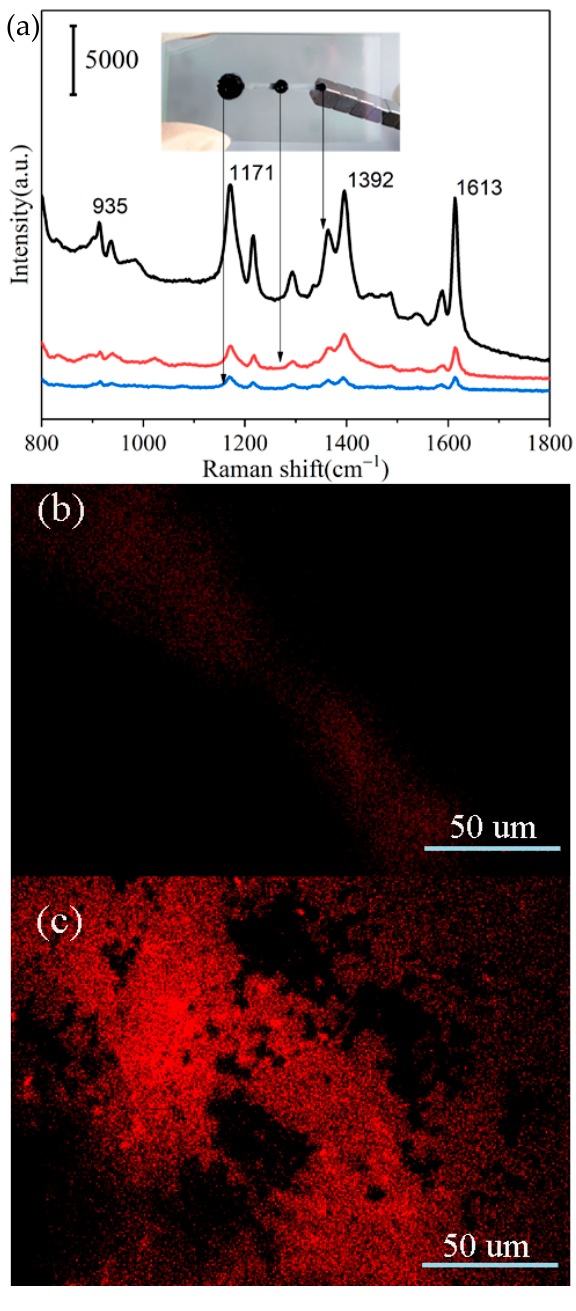
Figure 5. Photographic image of the microfluidic channel and corresponding SERS spectra at three reservoirs ( a ); fluorescence microscopic image of Rhodamine 6G (5 ppm) on AgMNPs from reservoir 1 ( b ) and reservoir 3 ( c ).